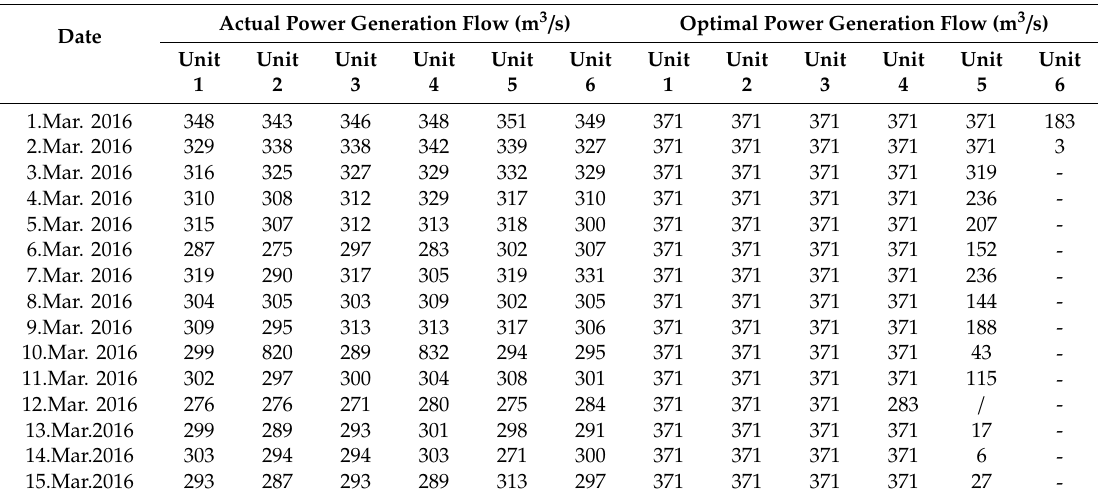
Table 3. The power generation flow distribution of units in actual and optimal